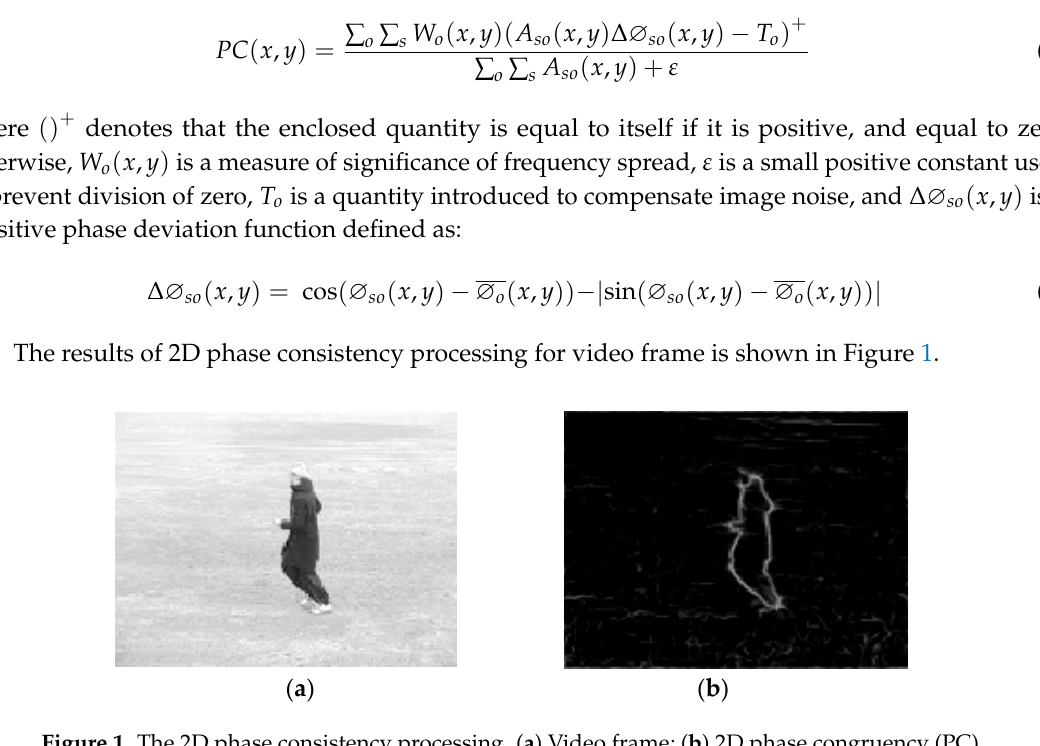
Figure 2. Inter-frame correlation.